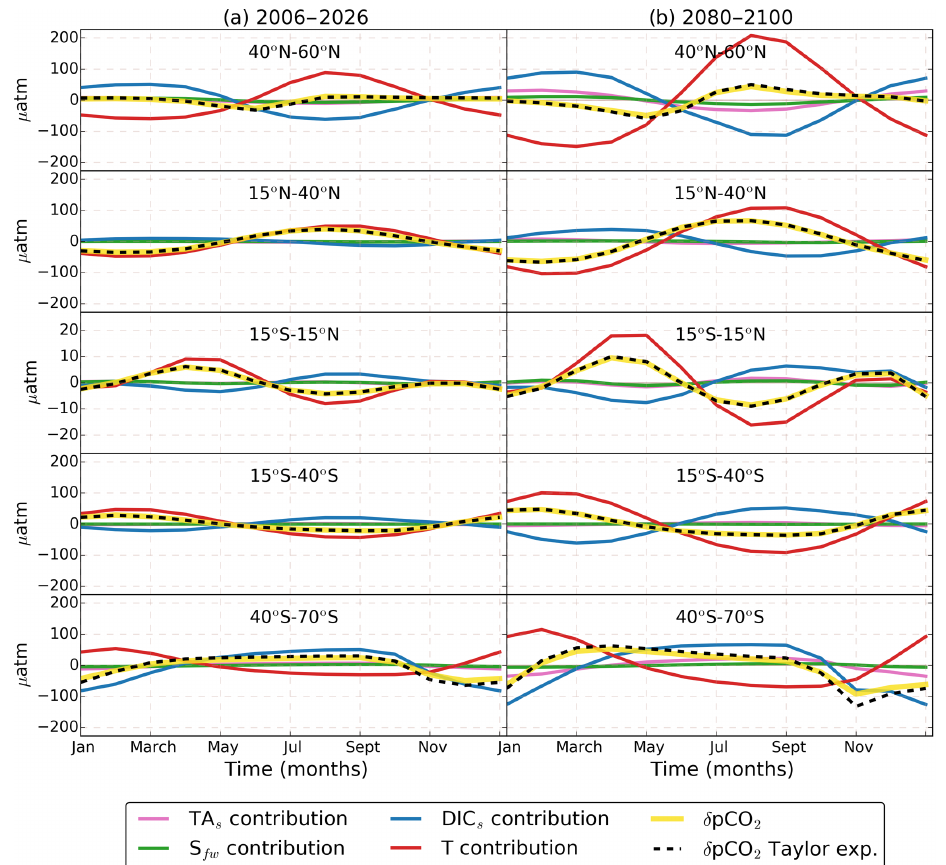
Figure 3. RCP8.5 ensemble mean seasonal cycle ( δp CO 2 ) and its Taylor decomposition. Colored lines indicate the contributions of DIC s (blue), TA s (pink), T (red), and S fw (green) to δp CO 2 reconstructed from its Taylor decomposition (Eq. 1; dashed black). δp CO 2 calculated from monthly p CO 2 (solid yellow) is shown for comparison with the Taylor expansion. Column (a) shows the period 2006–2026 and column (b) shows the period 2080–2100. Each row represents the global zonal average for a different latitudinal band. Temperature dominates all latitudes except the Southern Ocean. In the 40–60 ◦ N band, T contribution is largely compensated for by DIC. The TA s and S fw effects are rather small in all